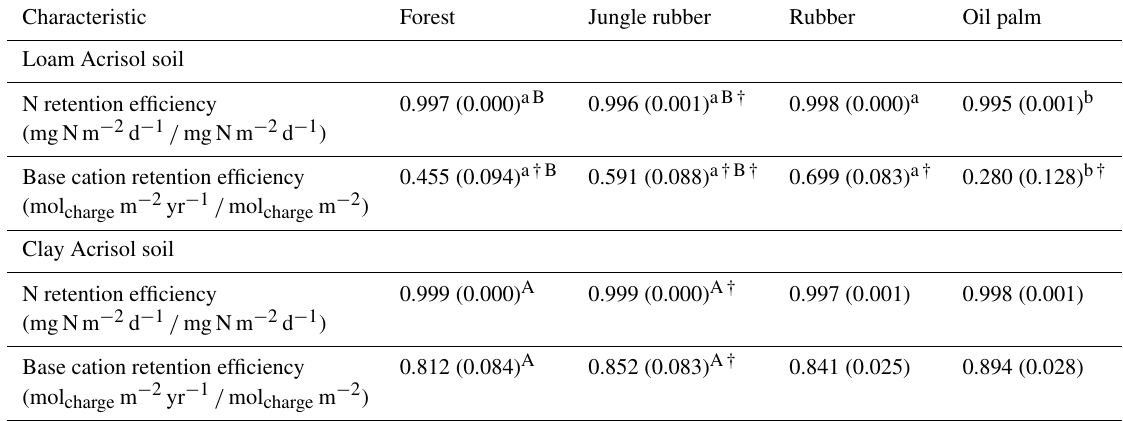
Table 5. Mean ( ± SE, n = 4, except for oil palm n = 3) nitrogen and base cation retention efficiency in soils under different land uses within the loam and clay Acrisol soils in Jambi, Sumatra, Indonesia. Means followed by different lowercase letters indicate significant differences among land uses within each soil type and different uppercase letters indicate significant differences between soil types for each reference land use (linear mixed-effects models with Fisher’s LSD test at P ≤ 0 . 05 and † at P = 0 . 07 for marginal significance).